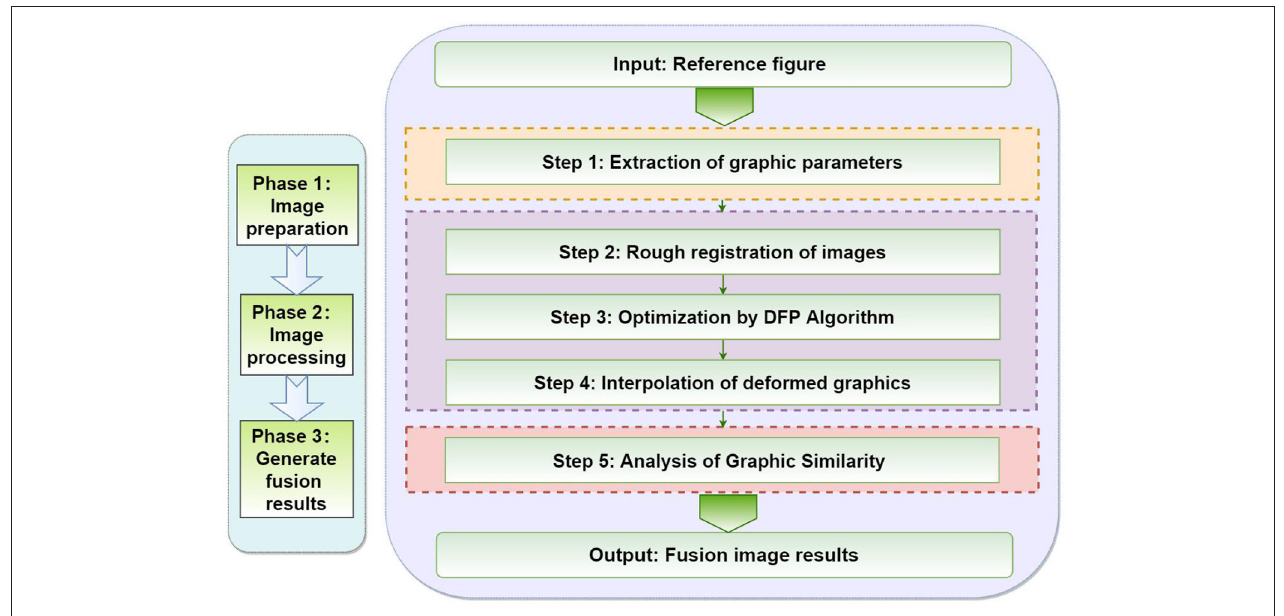
FIGURE 4 | Procedure followed by the proposed